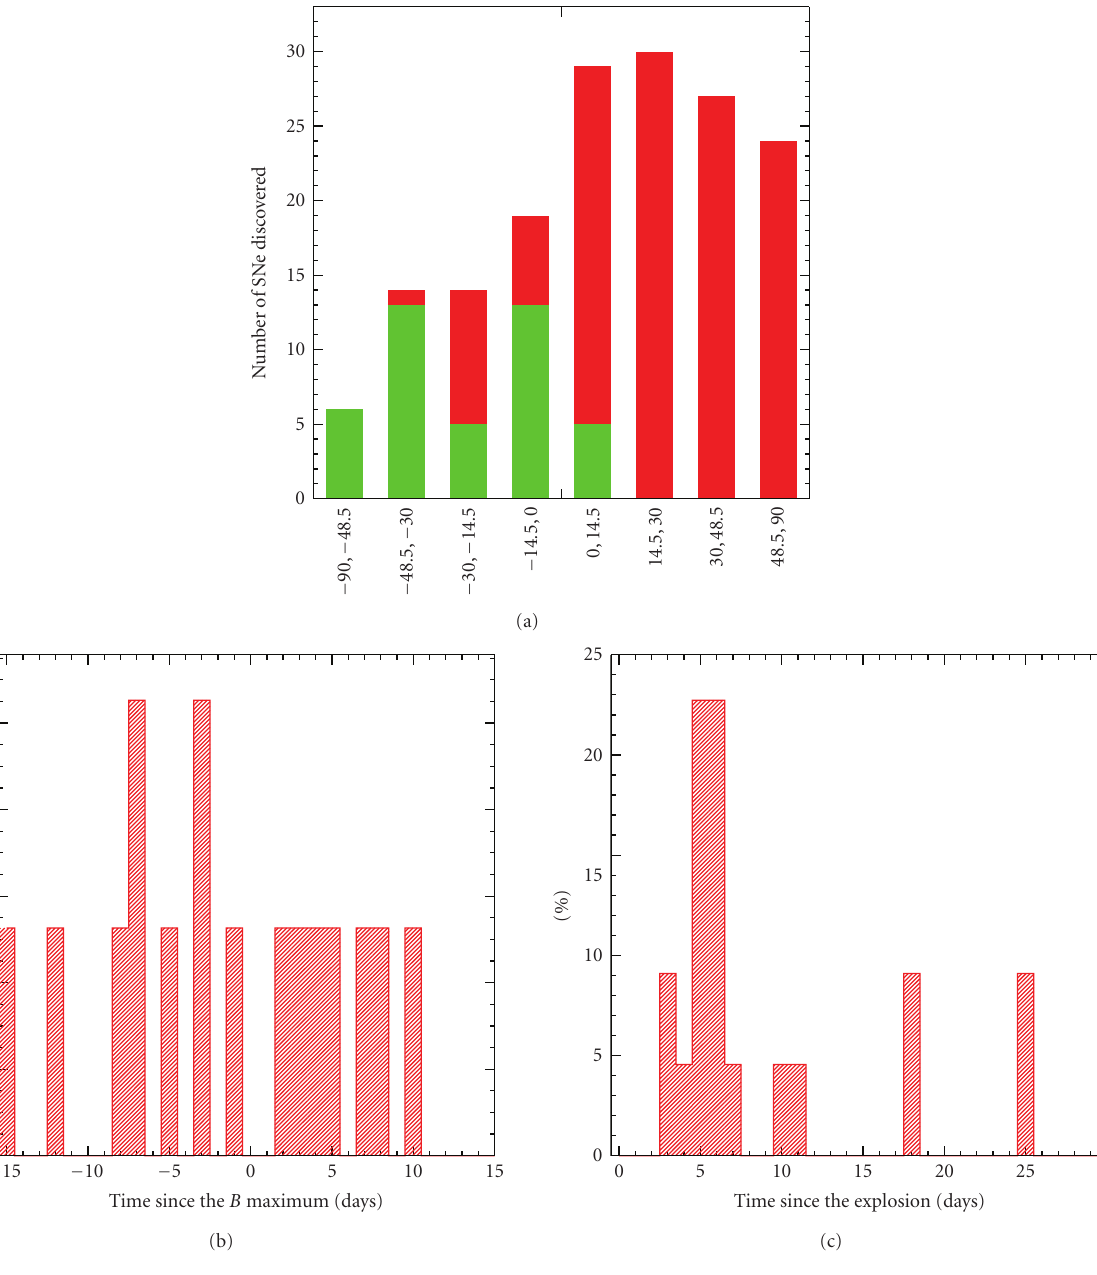
Figure 5: CHASE survey results. (a) the distribution of supernova with declination in bins of equal solid angle. Red bins correspond to all nearby SNe found in 2008, and green bins correspond to SNe discovered by CHASE in 2008. (b) the distribution of discovery ages of Type Ia SNe in CHASE. About half of the SNe were discovered before maximum. (c) the distribution of discovery ages of Type II SNe in CHASE. The median discovery age was about 5 days after explosion. (G. Pignata, private communication). The camera was chosen to avoid the potential presence of residual images in the imaging of targets, which currently dominate our SN candidate lists with the PROMPT tele- scopes, to obtain a relatively big field-of-view, which would allow us to image enough reference stars to do an accurate image alignment and subtraction, but also to obtain the best available quantum e ffi ciency, which is a cost-e ff ective way of collecting more photons per